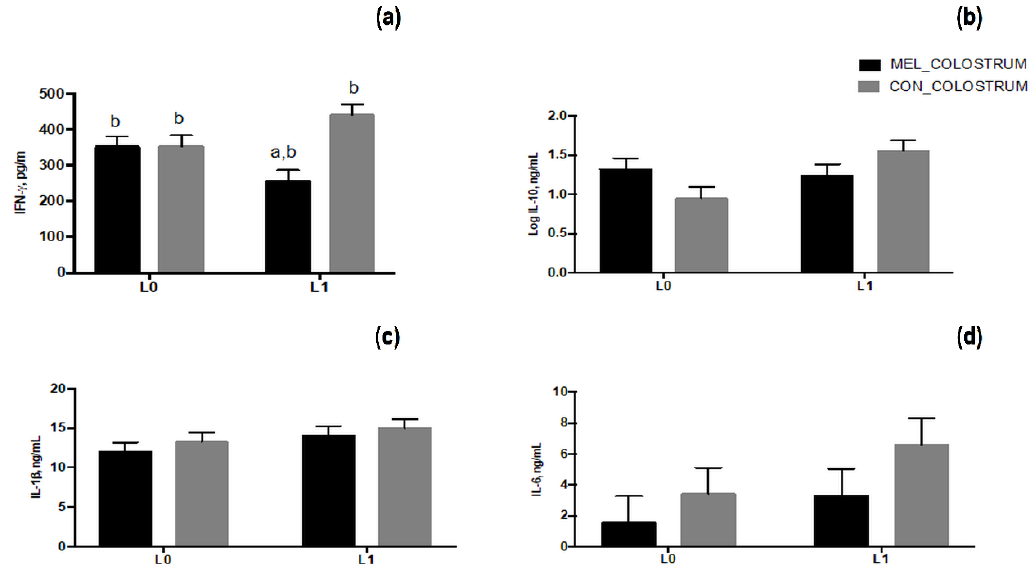
Figure 8. Least squares means ± SEM of levels of colostrum IFN- γ ( a ), IL-10, ( b ), IL-1 β , ( c ) and IL-6 ( d ) at lambing (L0) and 24 h later (L1) in control ewes (CON) and in melatonin ewes (MEL), p < 0.05, a: among the two groups, b: within time.